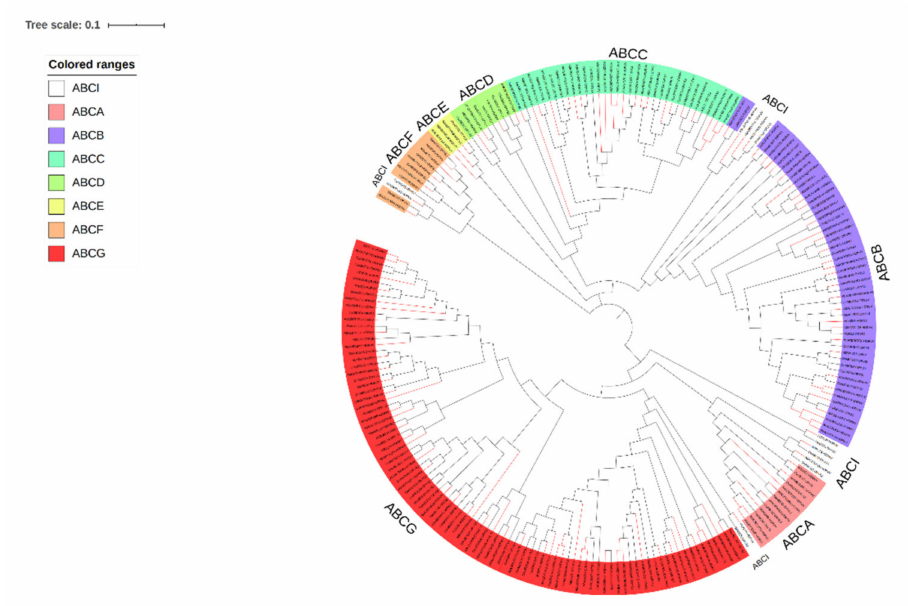
Figure 1. Unrooted Neighbor-Joining tree constructed with ABC proteins of Hordeum vulgare L. (HORVV) and Oryza sativa L. (ORYSJ). The domains clustered into eight subgroups (ABCA-ABCG, ABCI). Different colored shadings indicated eight ABC transporter subfamilies. The red branch is barley, and the black branch is